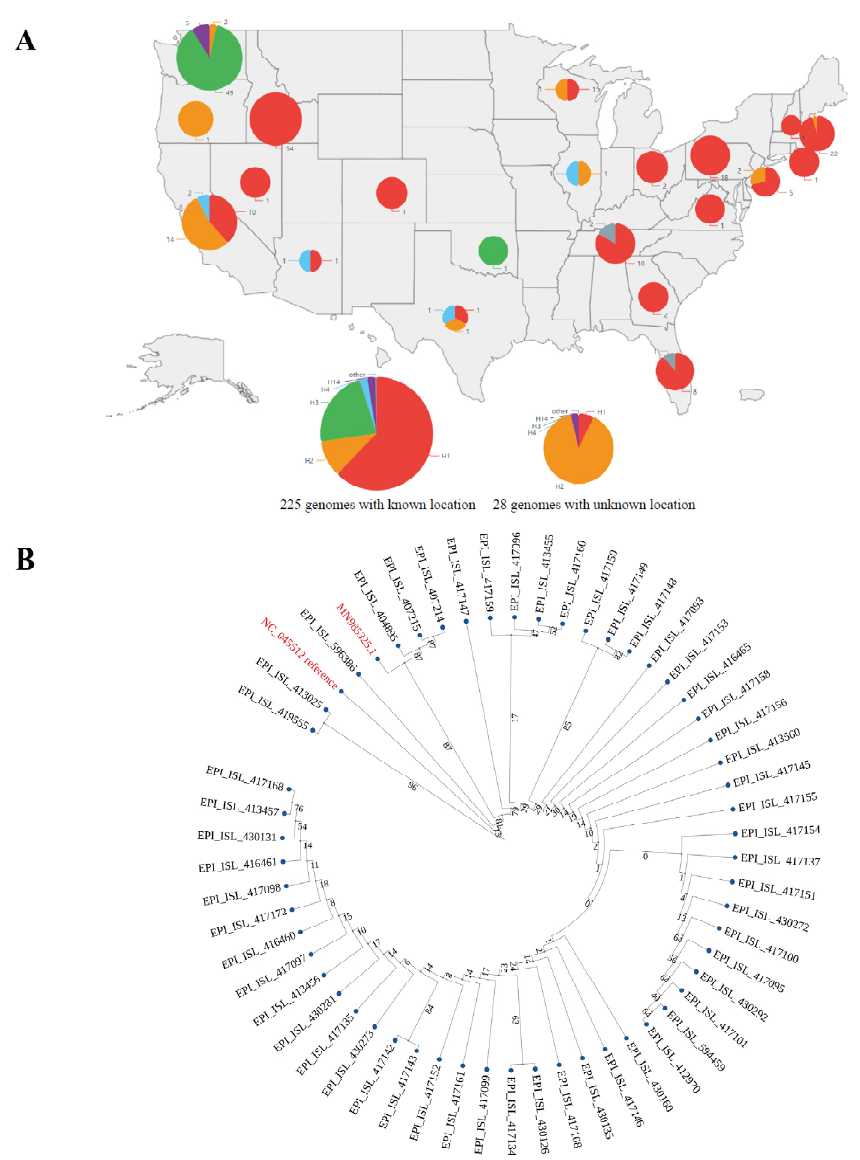
Figure 5. Early haplotype subtype distribution in the U.S. and the phylogenetic tree of early genome sequences in Washington State. ( A ) Genome sequences with the known location were plotted at the corresponding states of the U.S. on the map. ( B ) The reference sequence (NC_045512.2) and the genome sequences (MN985325.1) from the reported first case of the U.S. are marked in red.